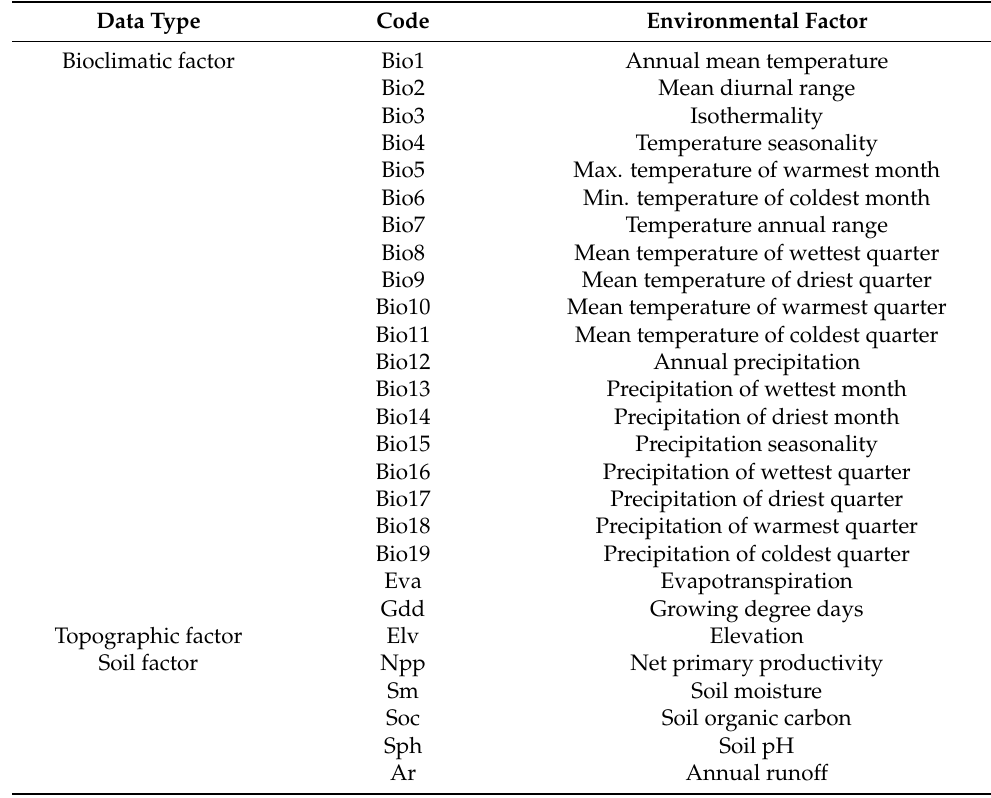
Table 1. Environmental factors used in this study and their